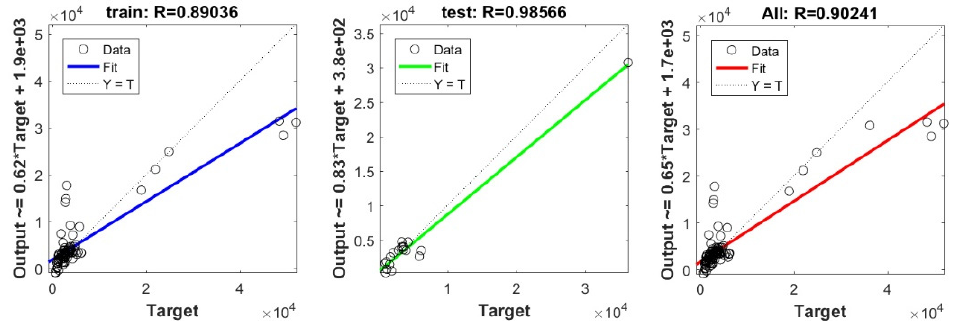
Figure A1. Scatter plots between target and output values by the SVR model.